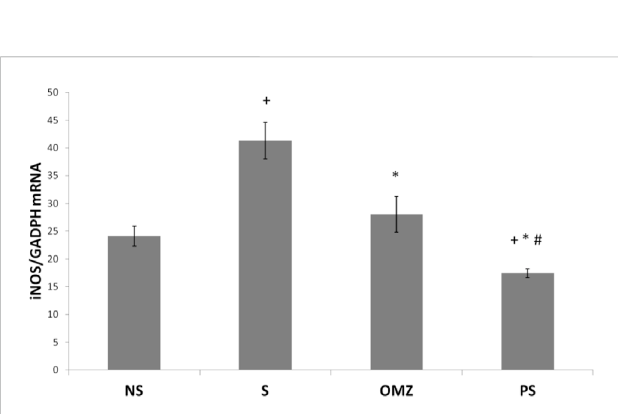
FIGURE 4 Effects of P. sarmentosum (500 mg/kg; PS) and omeprazole (20 mg/kg; OMZ) on gastric iNOS mRNA levels in rats exposed to WIRS for3.5 h.Barsrepresent mean±SEM ( n =7).Key:+, p < .05comparedto thenon-stress(NS)controlgroup;*, p < .05compared tothestress (S)controlgroup;#, p < .05comparedtotheomeprazole-treatedgroup.